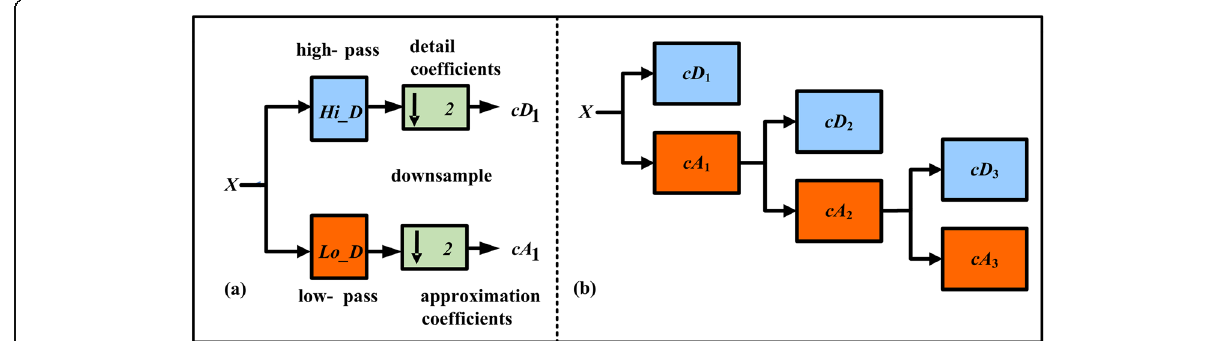
Fig. 2 a The classical DWT decomposition (Mallat algorithm). b The multi-level DWT decomposition